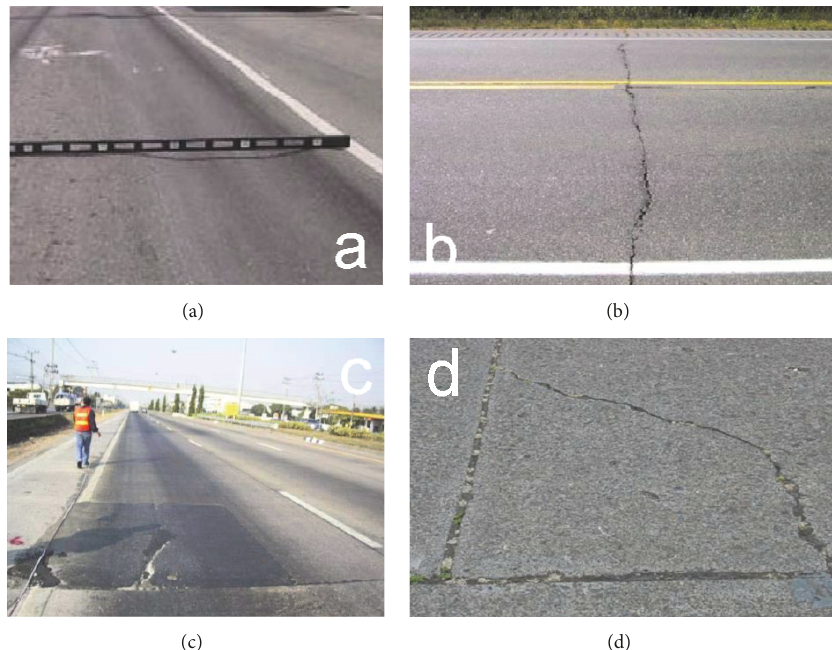
Figure 1: Examples of road distresses in Thailand . Ordering from (a), (b), (c), and (d) are rutting, transverse crack, bad patching, and corner crack, respectively (images from [7, 8]).